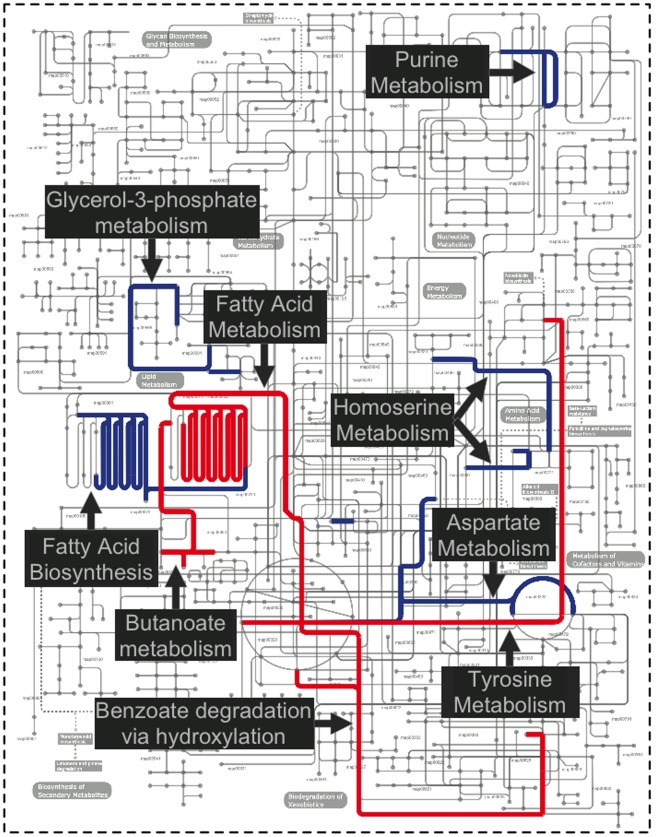
Metabolic pathways present in our samples.Dark blue – significantly enriched in healthy samples (p<0.05, MetaPath [84]); Dark red– significantly enriched in diseased samples (p<0.05, MetaPath). (Figure constructed with iPath [85]).